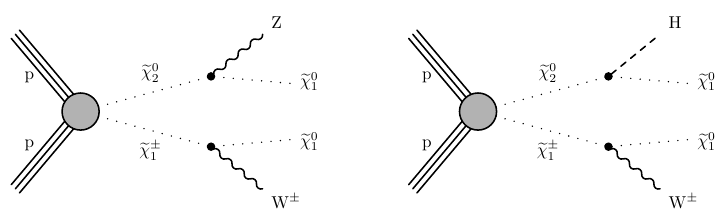
0 with subsequent decay of 2 1 e c